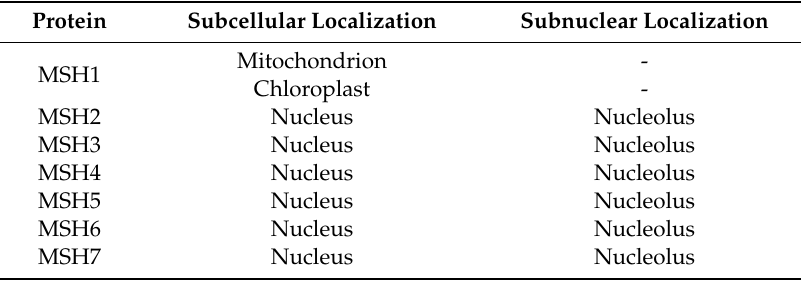
Table 5. Subcellular localization of AtMSH